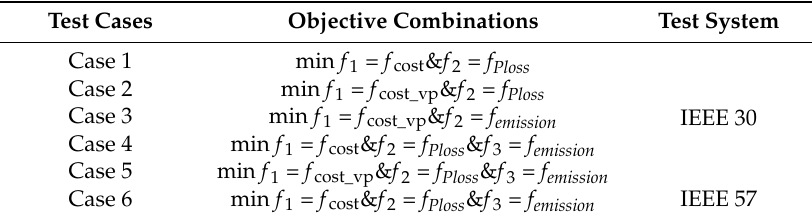
Table 3. Different objective combinations of MOFA-CPA and MOFA-PFA.